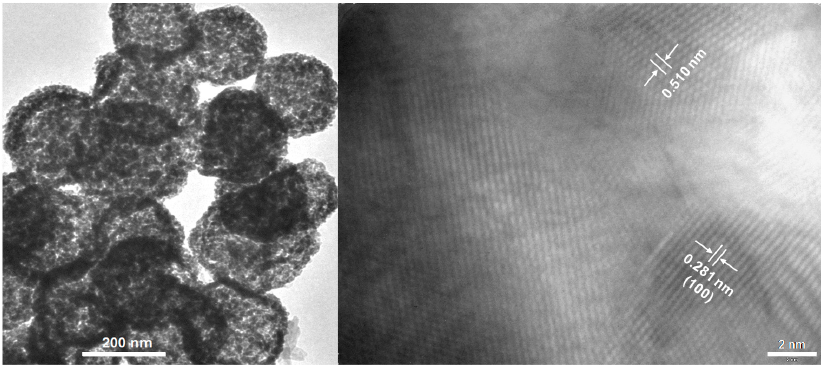
Figure 2. (High-resolution) TEM images of the crystalline ZnO -MeOH NPs with visual lattice fringes (correspond to crystal planes). Table 1. Particle size determined by TEM and XRD data and absorption peak from UV spectra.